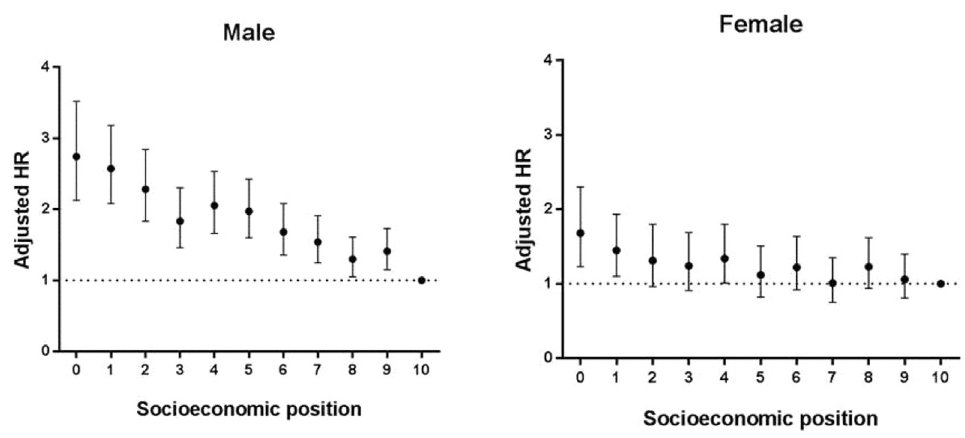
Fig. 2. Hazard ratios across socioeconomic positions (in deciles, with 0 representing Medicaid recipients strati fi ed by gender. HRs adjusted for age, geographical location, and disability level. HR, hazard ratio.